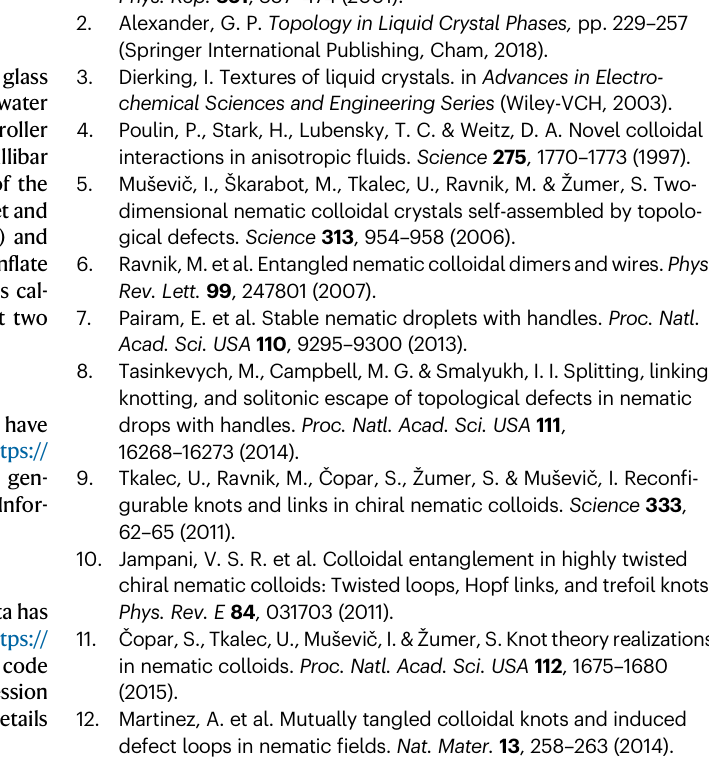
indicatedbytheblueandredarrowsgivesrisetolocalshear fl owthatfrustratesand ultimately breaks the polar vectorial orientation fi eld in the yellow-shaded region. This gives rise to a pair of +1 and − 1 winding number topological defects, with +1 defect drifting with the LC fl ow in front of − 1 defect. Therefore, the difference between( a )and( b )isinthesymmetryofthe fl owpattern,inthetypeof theelastic mode (bend vs. splay) and in the symmetry of the order parameter (nematic vs